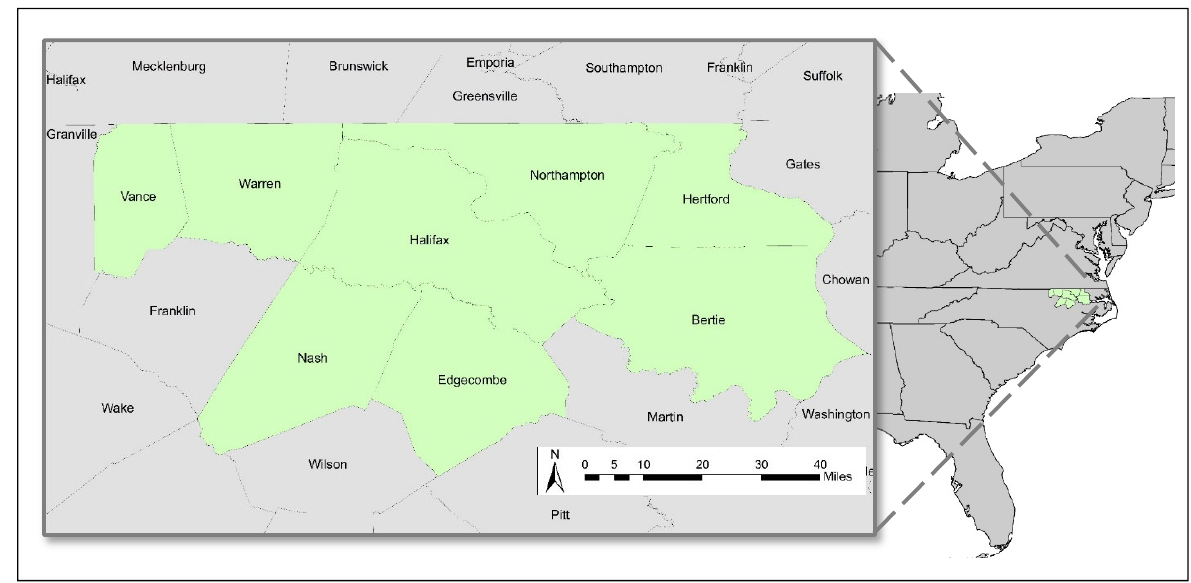
Figure 1. Eight-County Project Region in Inner Northeastern North